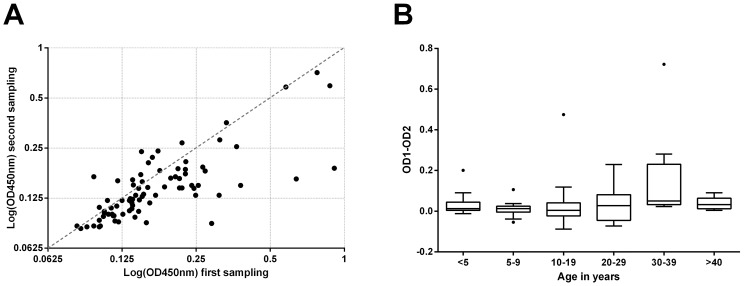
Changes in anti-M. ulcerans 18 kDa shsp IgG titres in sequentially collected serum samples.
A IgG titres against the M. ulcerans 18 kDa shsp were determined in serial serum samples collected from 80 individuals. The majority of changes were small and most individuals showed a slightly decreased titre after one year. B Boxplot of differences in OD values between the two samples are shown by age group. Changes in antibody titres were most pronounced in young adults.